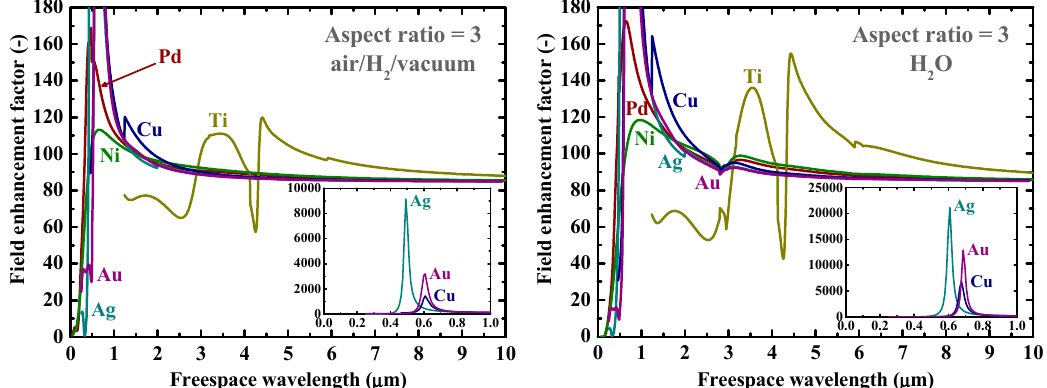
Figure 3. Calculated electromagnetic field enhancement factors at the tips of spheroidal nanoparticles of Au, Ag, Cu, Pd, Ti, and Ni with an aspect ratio of 3 in ( left ) air/H 2 /vacuum and ( right ) H 2 O. The insets are the clarified plots for Au, Ag, and Cu.